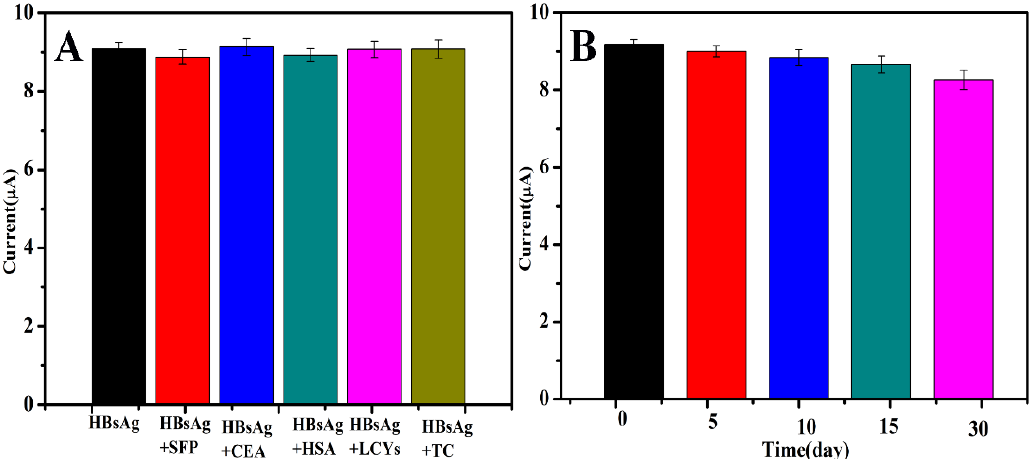
Figure 7. ( A ) Selectivity of the immunosensor to 100 ng/mL HBsAg, 100 ng/mL HBsAg + 100 ng/mL AFP, 100 ng/mL HBsAg + 100 ng/mL, 100 ng/mL HBsAg + 100 ng/mL HAS, 100 ng/mL HBsAg +